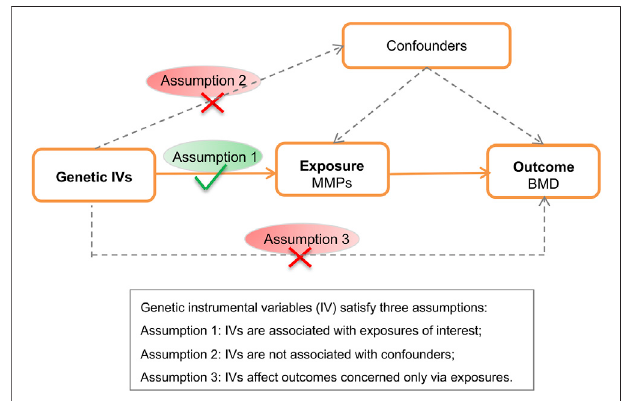
FIGURE 1 | Schematic of the Mendelian randomization analysis. BMD, bone mineral density; MMP; matrix metalloproteinase; SNP, single nucleotide